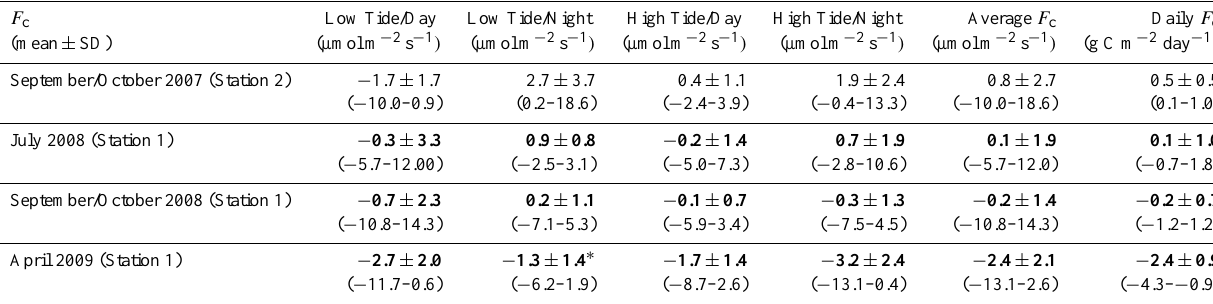
Table 1. Carbon dioxide fluxes ( F c ) (mean ± standard deviation) measured in the Arcachon flat in September/October 2007 at Station 2 and July 2008, September/October 2008 and April 2009 at Station 1 (see Fig. 1). Negative fluxes represent sinks of CO 2 and positive fluxes represent sources of CO 2 to the atmosphere by convention. Averaged F c values have been obtained computing the average over the whole data set for each of the four periods. Daily F c values represent the average over the averages obtained for every entire days of each period and converted into gCm − 2 day − 1 (90%, 92%, 97% and 96% of data were used, for the deployments in autumn 2007, summer 2008, autumn 2008 and spring 2009 respectively). A PAR threshold of 20µmolm − 2 s − 1 has been chosen to separate day and night cases and high tide cases corresponding to non-zero water heights. ∗ Negative F c data corresponding to very short periods of low tide/night and very fast changes in CO 2 fluxes in April 2009 (Days 94 and 96, Fig. 6e) were excluded from the average, as they were potentially affected by flooded